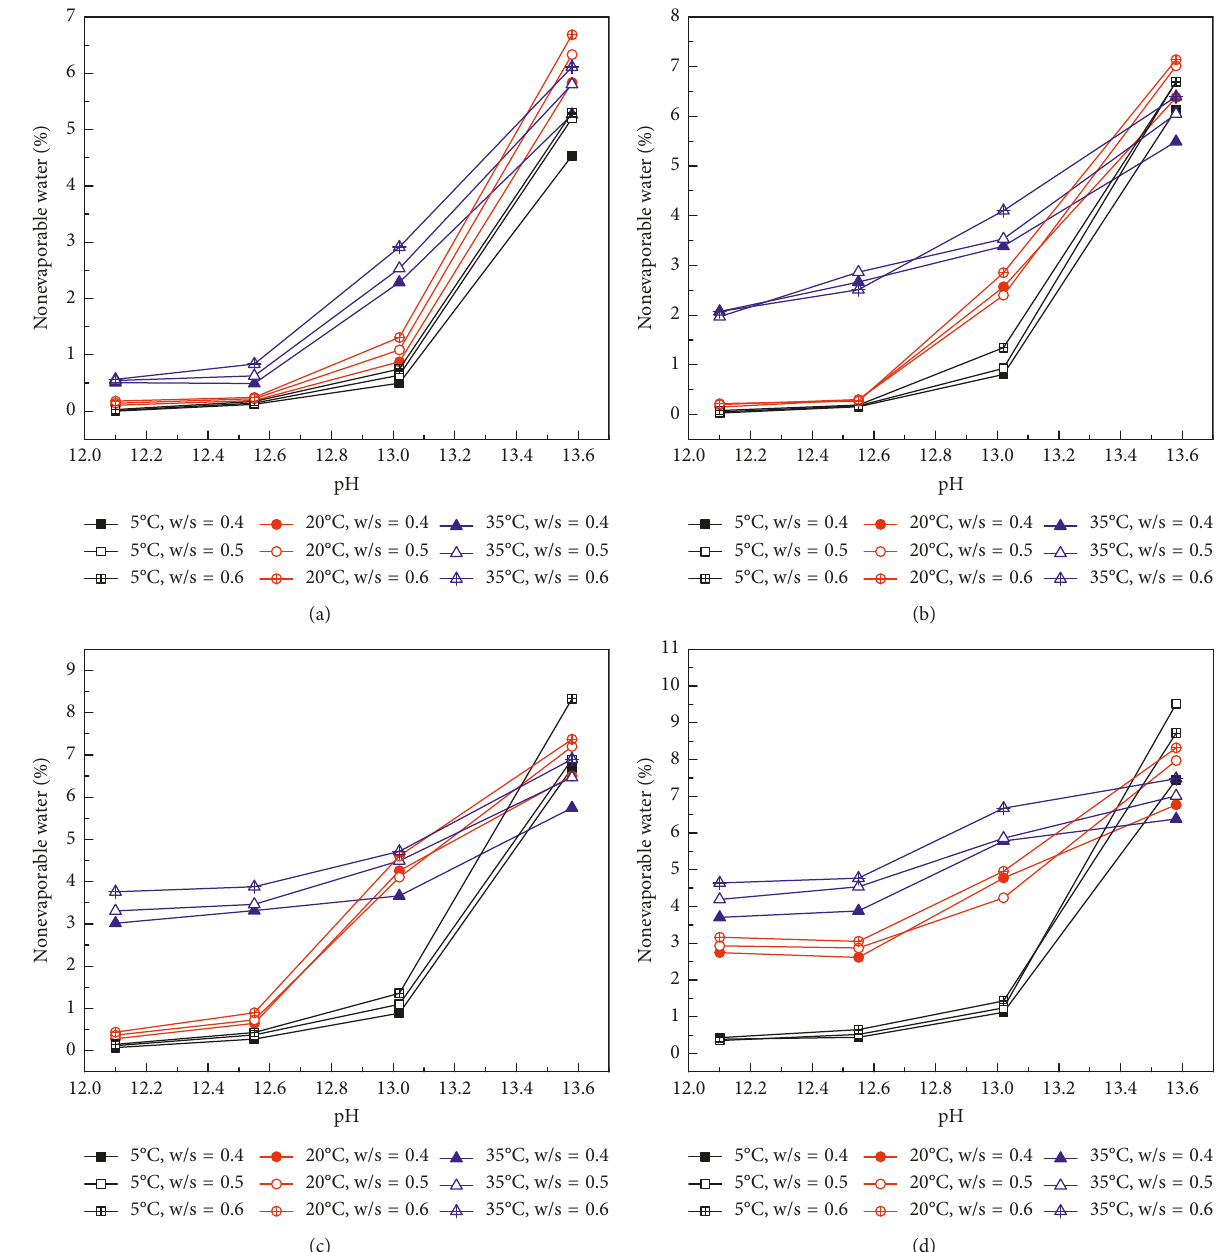
Figure 1: Variation of the NEW content of AAS paste with pH at different ages. (a) 1day; (b) 3days; (c) 7 days; (d)